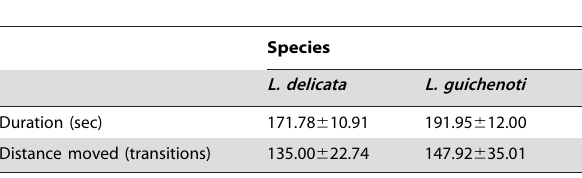
Table 2. Duration of post-autotomy tail movement ( 6 SE) in Lampropholis delicata and L. guichenoti , and the distance ( 6 SE) that the shed tails